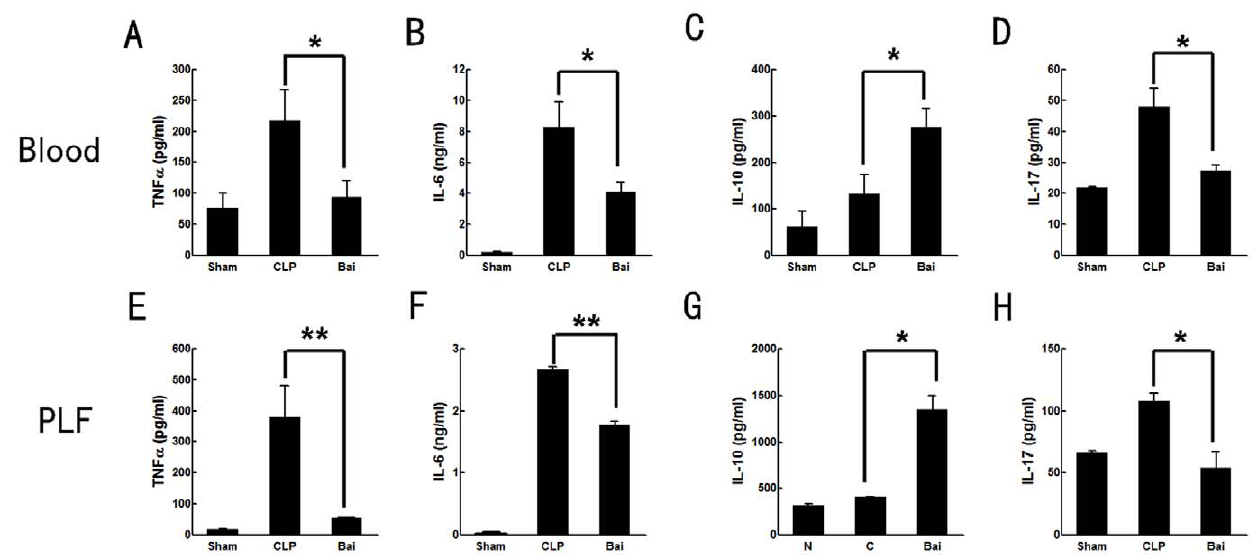
Figure 5. Cytokines expression of septic mice after baicalin injection. Baicalin reduced excretion of proinflammatory cytokines while increased anti-inflammatory cytokine. Samples were collected 24 h after CLP. Proinflammatory cytokines included TNF-alpha, IL-6 and IL-17 (A, B, D in blood and E, F, H in peritoneum). IL-10 represented the anti-inflammatory cytokine (C in blood and G in peritoneum). PLF, peritoneal lavage fluid; Bai, baicalin group; CLP, CLP group. Data analyses with one-way ANOVA and Newman-Keuls. * P , 0.05, ** P , 0.01. doi:10.1371/journal.pone.0035523.g005 group comparisons were performed by Dunn’s test. A signifi- cance level of 0.05 was considered to be significant for all calculations.